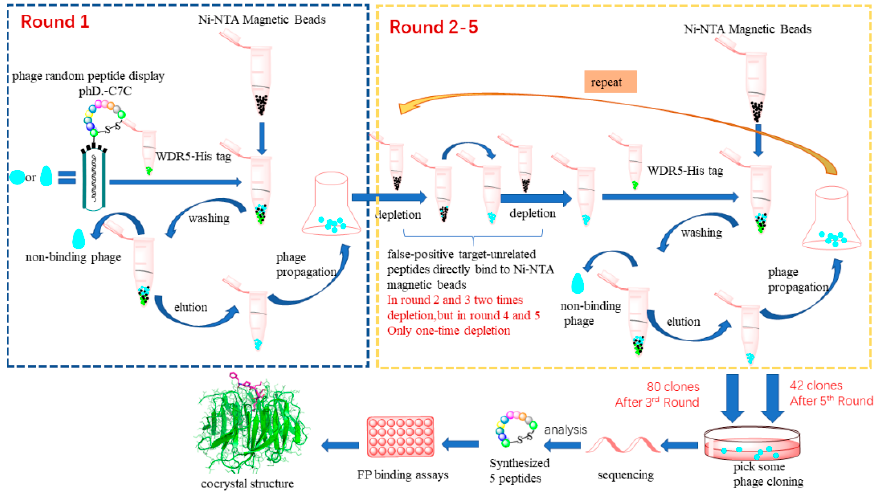
Figure 4. The flowchart of the whole phage display screening process.